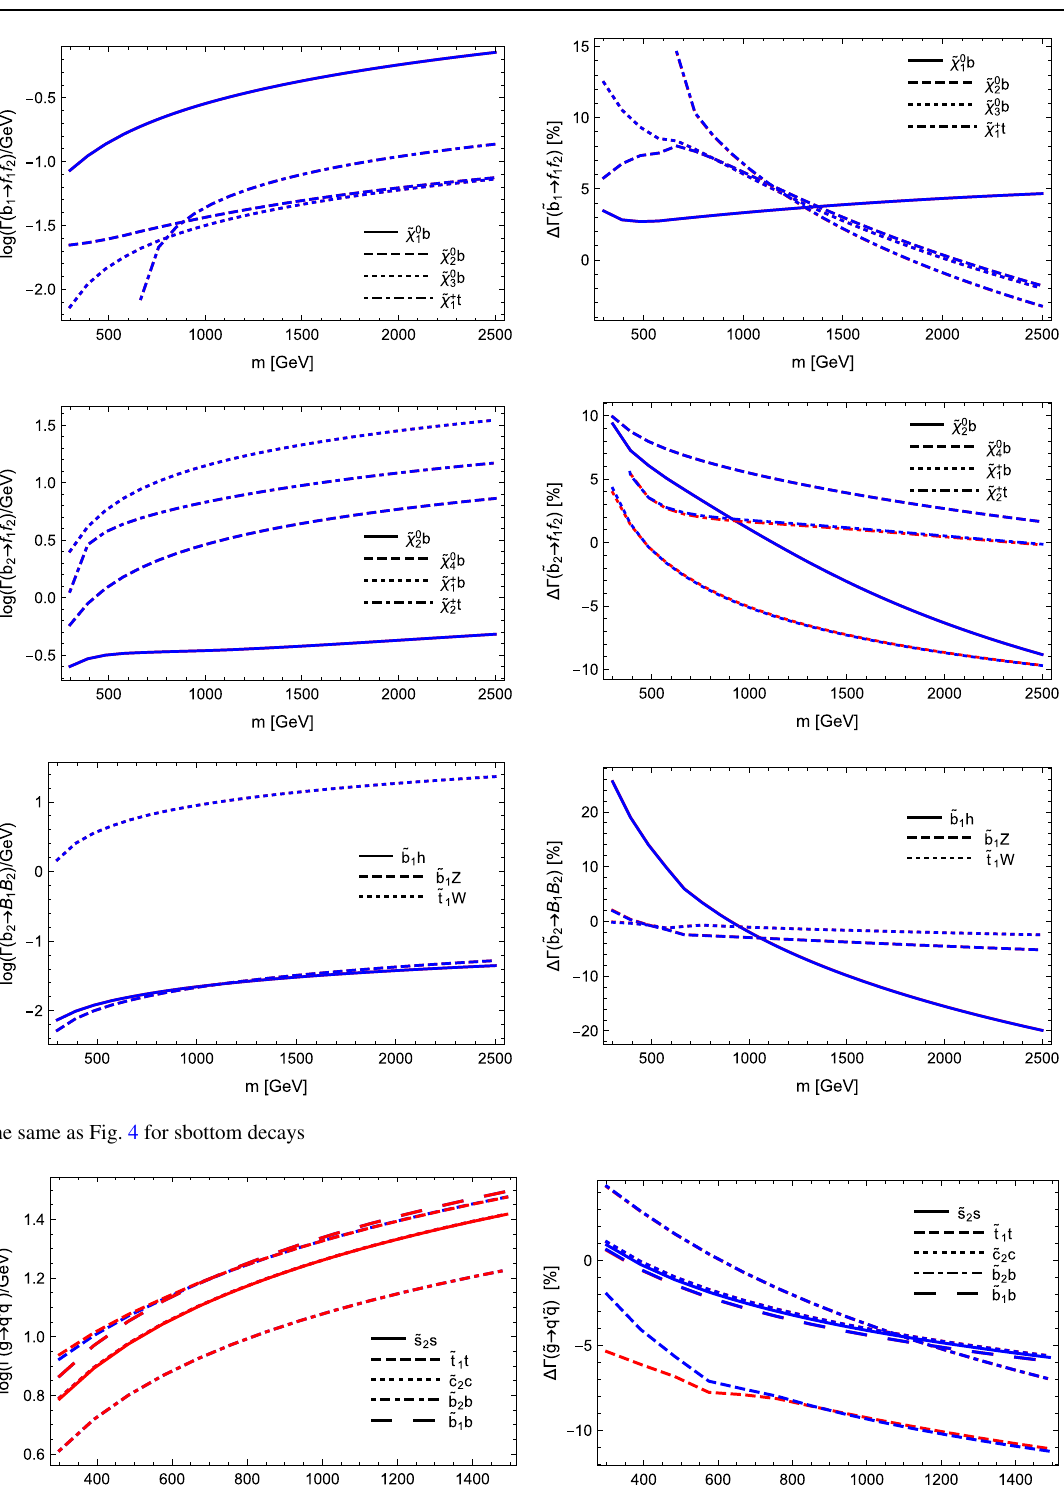
Fig. 6 Comparison between SARAH and FVSFOLD for gluino decays. On the left, the loop-corrected partial widths are shown. On the right, the relative size of the one-loop correction is given. Blue lines are obtained with SARAH , red lines with